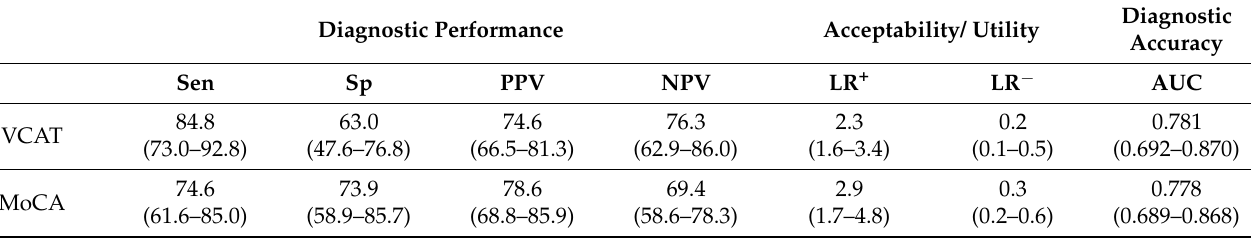
Table 5. Overall diagnostic performance, clinical acceptance/ utility and diagnostic accuracy of VCAT and MoCA for mild dementia (AD + VAD) and MCI.